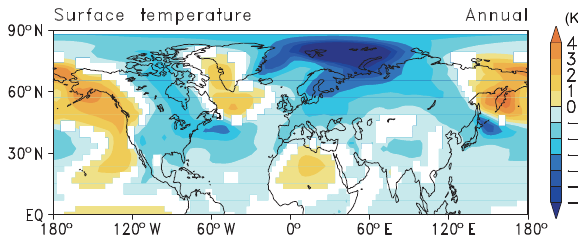
Figure 14. Similar to Fig. 13, except for annual mean surface tem- perature differences between weak and strong stratospheric west- erly jet experiments, comparable to an extended period of extreme solar minimum (Maunder Minimum-like) conditions. Colour shad- ing indicates regions where statistical significance exceeds the 95%